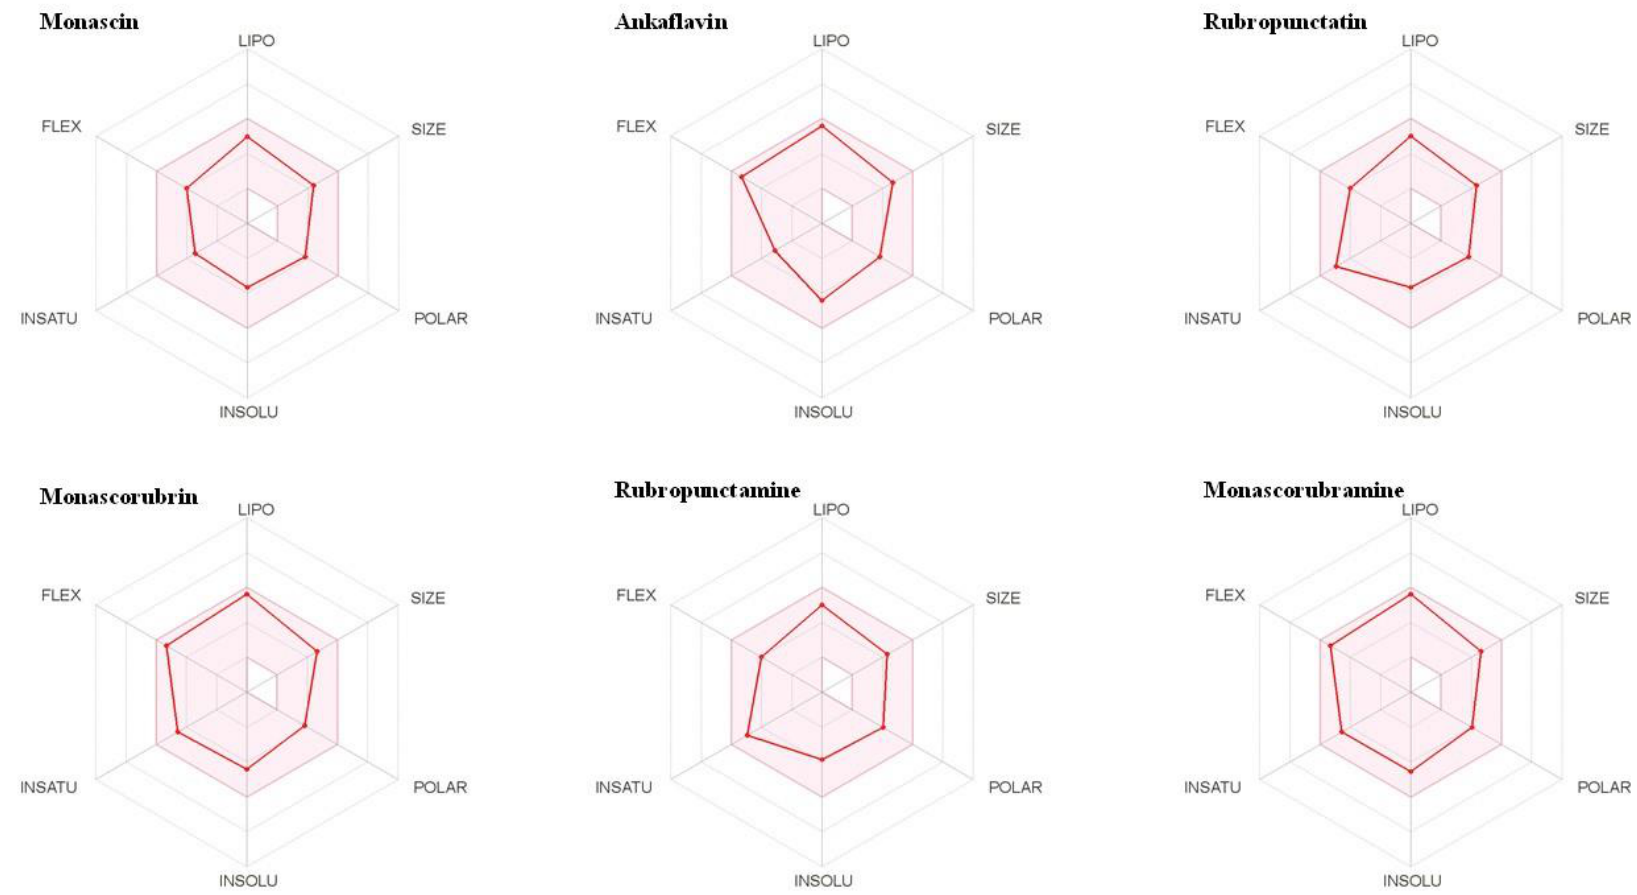
Figure 4. Bioavailability radar of the Monascus pigments based on physicochemical indices ideal for oral bioavailability. LIPO, Lipophilicity: − 0.7 < XLOGP3 < þ5; SIZE, Molecular size: 150 g / mol < mol. wt. < 500 g / mol; POLAR, Polarity: 20 Å2 < TPSA < 130 Å2; INSOLU, Insolubility: 0 < Log S (ESOL) < 6; INSATU, Insaturation: 0.25 < Fraction Csp3 < 1; FLEX, Flexibility: 0 < Number of rotatable bonds < 9. The coloured zone is the suitable physicochemical space for oral bioavailability.